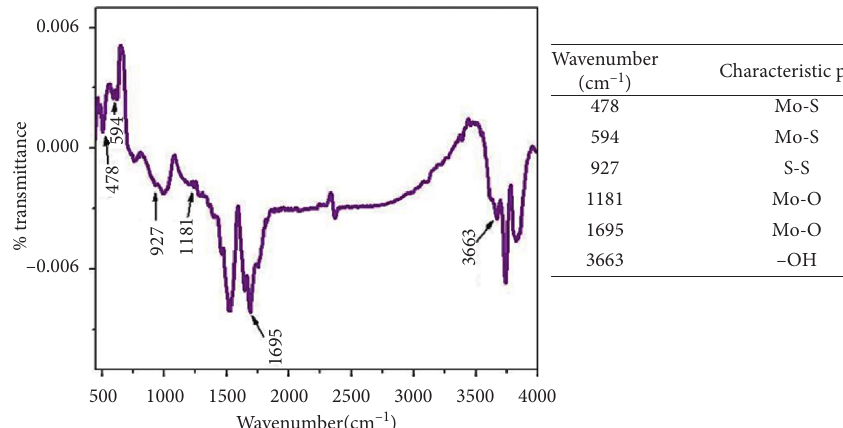
Figure 7: FTIR of pristine MoS